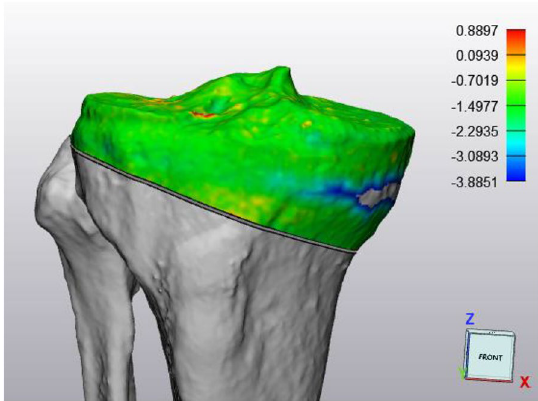
Fig. 4 3D matching of the pre-and postoperative proximal tibia plateaus, above the osteotomy level. Average distance error between bone models was 0.0716 0.0019 ±